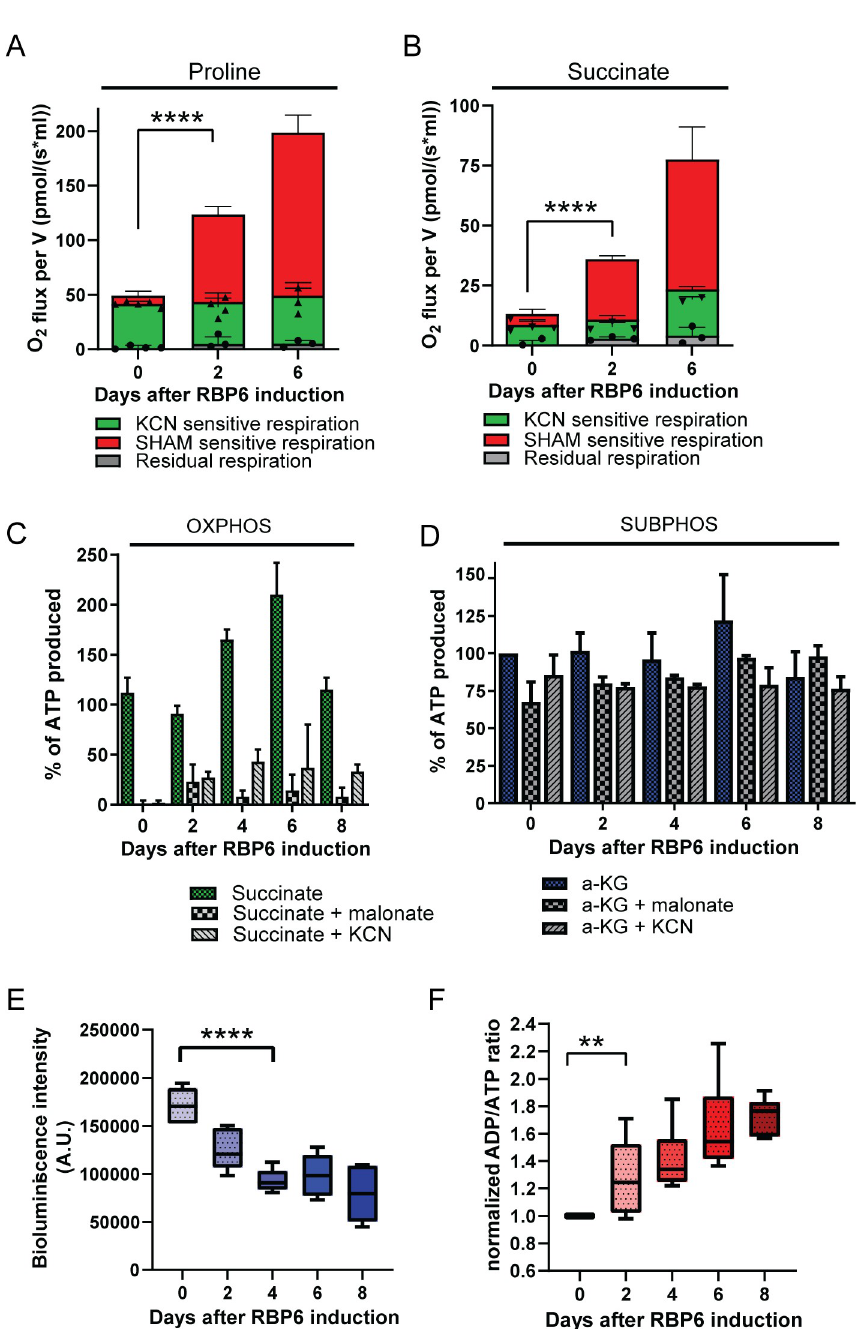
Fig 8. Changes in cellular respiration and mitochondrial ATP production in RBP6 OE cells. (A, B) Oxygen consumption rates in the presence of 5 mM proline (A) or 5 mM succinate (B) in live or digitonin-permeabilized cells, respectively. Respiration via AOX was monitored in the presence of KCN (0.5 mM). Individual values shown as dots (means ± SD, n = 3–5). ���� P < 0.0001. (C, D) The in vitro ATP production by oxidative or substrate phosphorylation (OXPHOS, SUBPHOS) measured in digitonin-extracted mitochondria from uninduced and RBP6-induced cells. The phosphorylation pathways are triggered by the addition of ADP and by succinate (C) or α -ketoglutarate (a-KG, D). Malonate (mal.) and KCN, specific inhibitors of succinate dehydrogenase and complex IV are used to inhibit ATP production by OXPHOS. The levels of ATP production in mitochondria isolated from uninduced RBP6 OE cells are established as the reference and set to 100% (means ± SD, n = 2–4). (E) Cellular ATP content in RBP6 OE cells. (means ± SD, n = 6, ���� P < 0.0001). (F) Relative ADP/ATP ratios of RBP6 OE cells. The ADP/ATP ratio in uninduced RBP6 OE cells (between 1.75 and 6.01) is established as a reference and set to 1. In T . brucei , ADP/ATP ratio